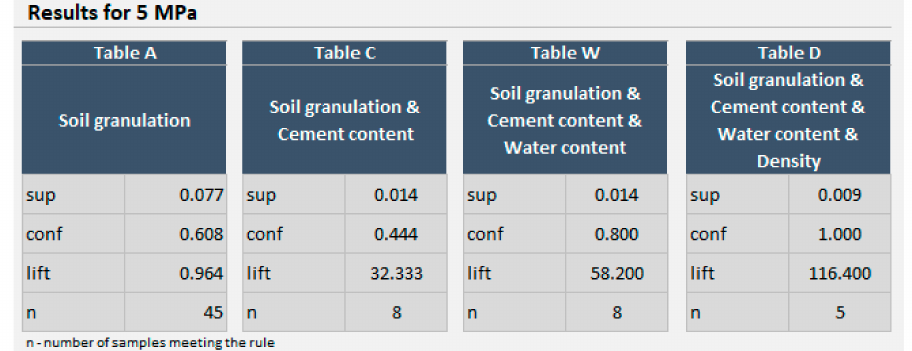
Figure 16. The screenshot of the calculator. Parameters of the rules for achieving 5 MPa presented for different predecessors